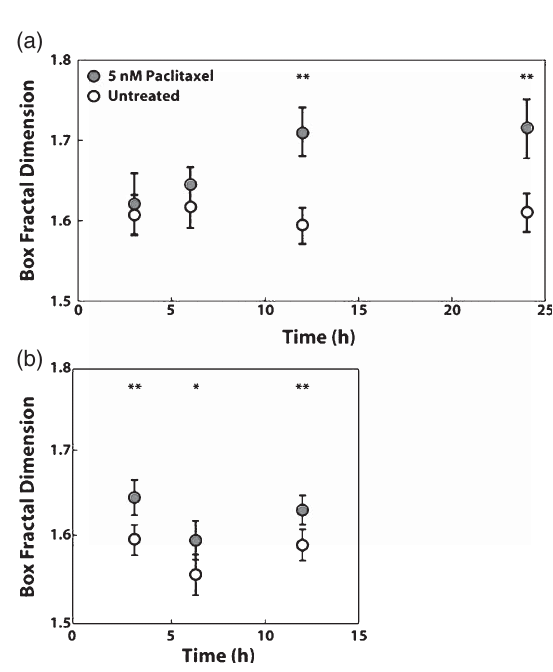
Fig. 15. Change in the fractal dimension observed in images of stained MCF-7 cell (a) nuclei and (b) mitochondria after treatment with 5nM Paclitaxel for 3, 6, 12, and 24 hours or 3, 6, and 12 hours, respectively. *indicates statistical significance ( p <0.05) and **indicates high statistical significance ( p <0.001). Adapted from